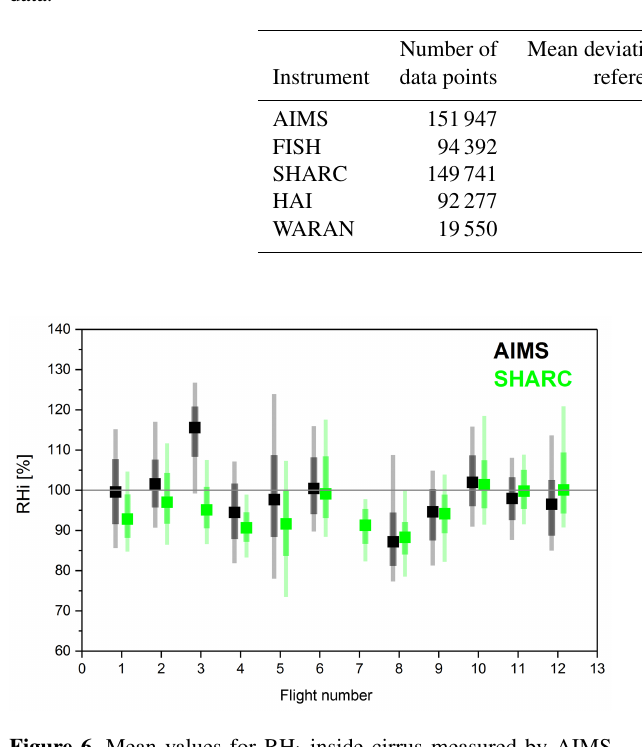
Table 2. Statistic summary of the five instruments including number of points entering the comparison, mean deviation and spread of the data.